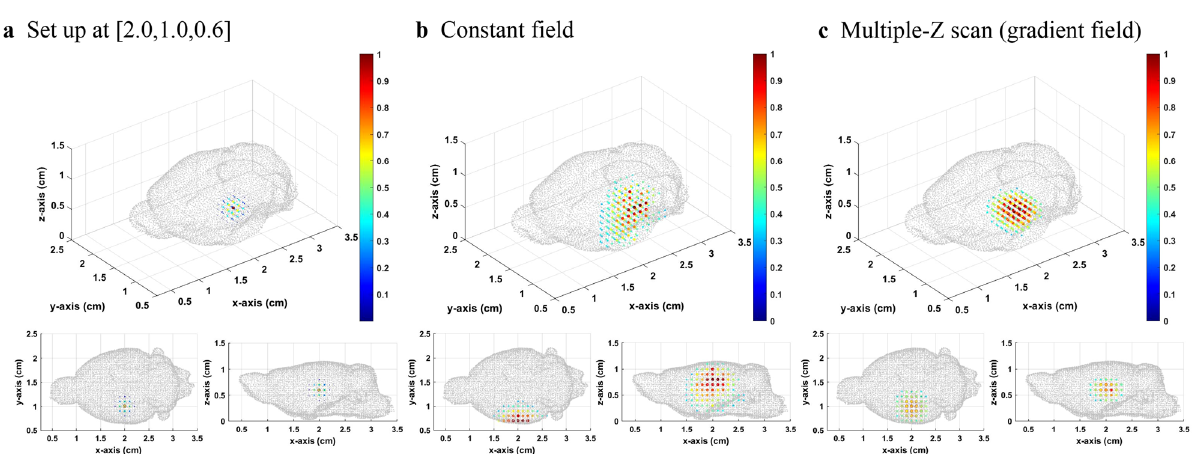
Figure 6. ( a ) The original source distribution center at [2.0,1.0,0.6], ( b ) inverse distribution calculated from the lead field matrix of MPI system with the constant field, and c inverse distribution result from the multiple Z scan (gradient field) with thresholds equal to 0.3.